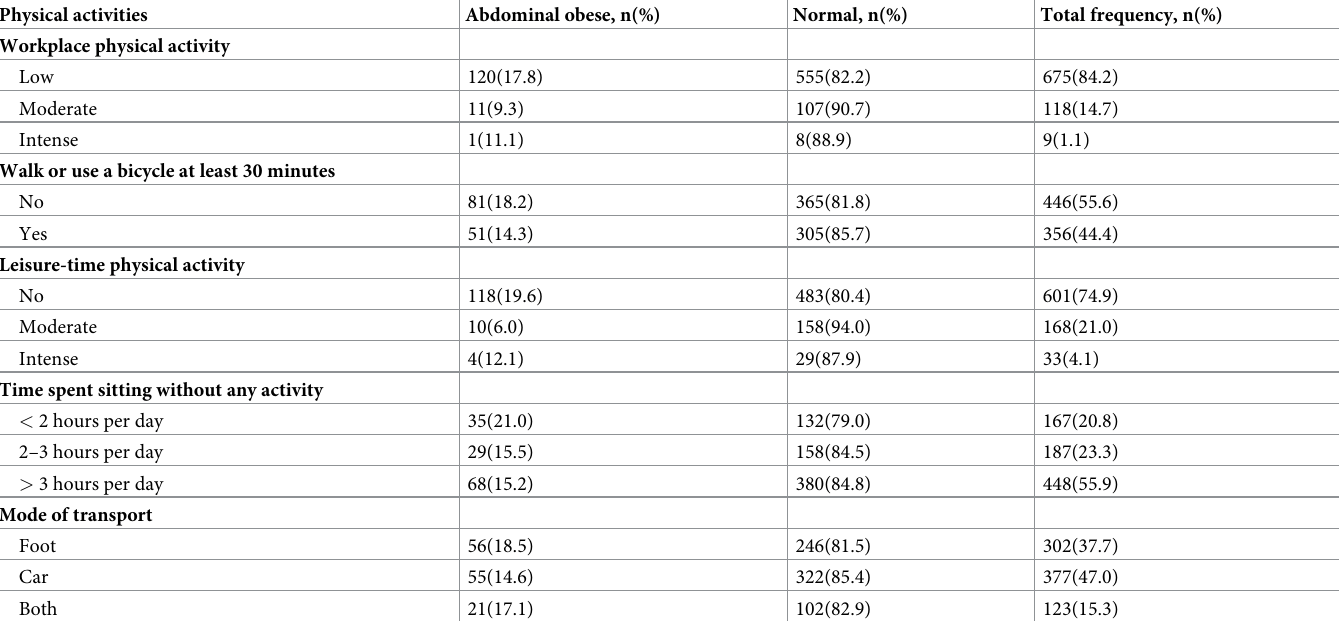
Table 3. Physical activities among adult population in Woldia town, Northeast Ethiopia, 2020.